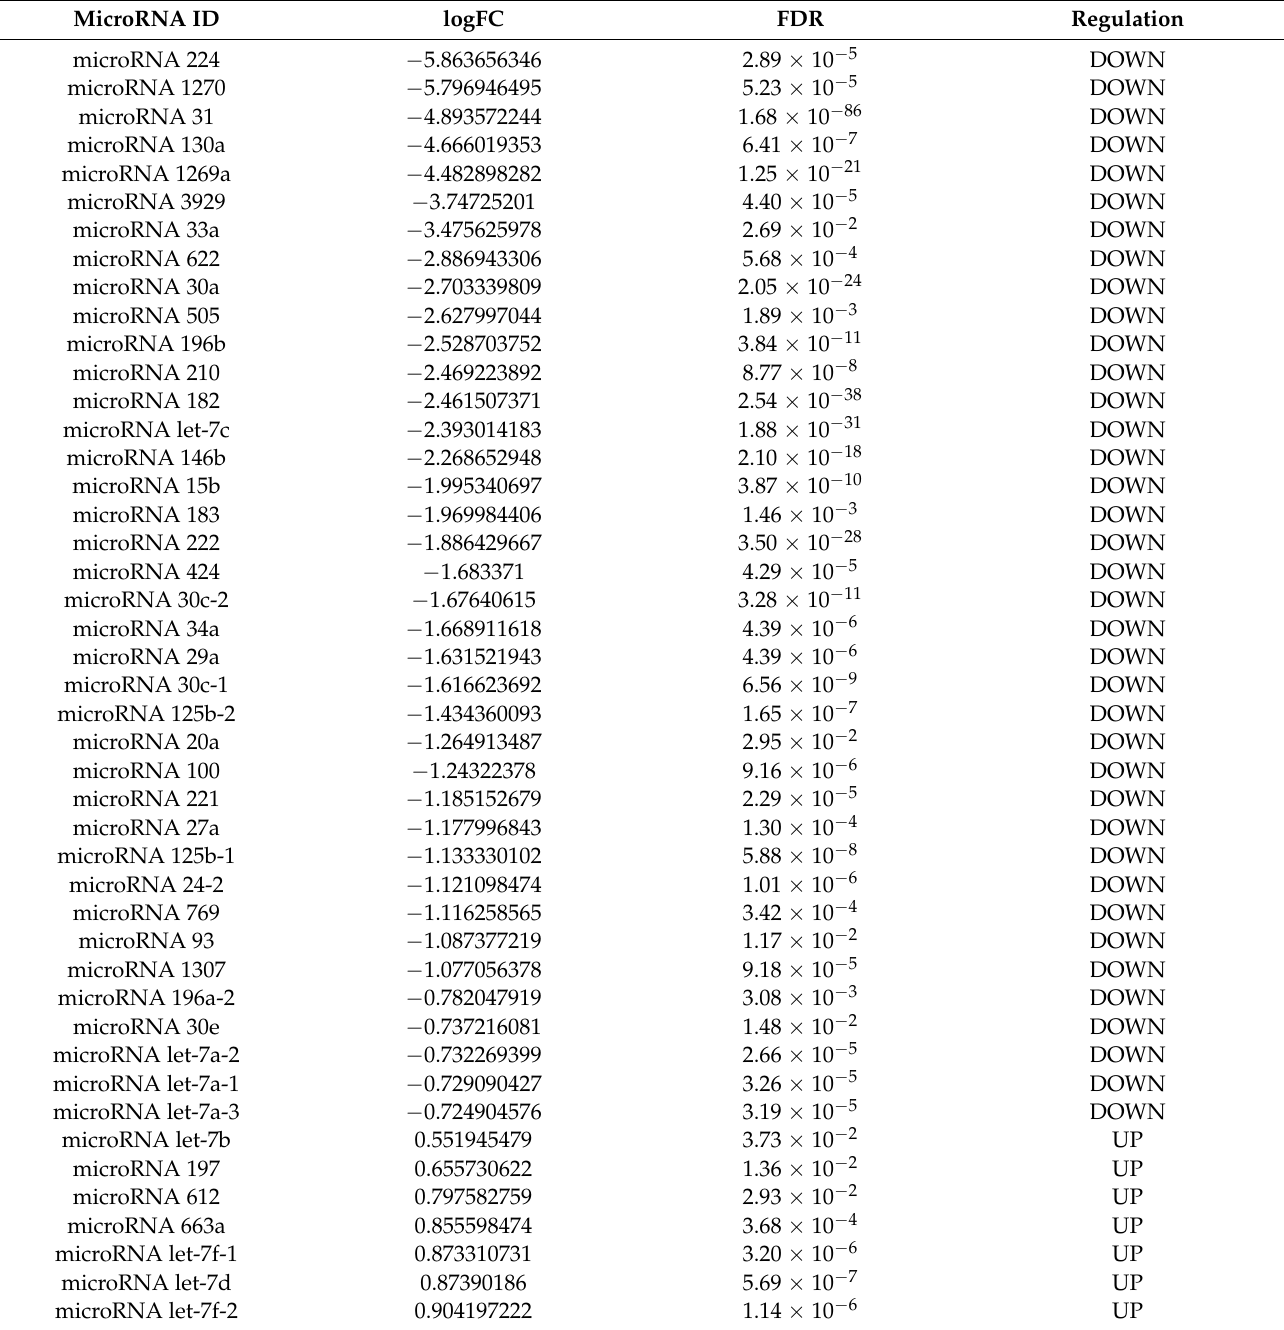
Table 1. Differentially Expressed microRNAs between A375 and A375-BIR melanoma cell